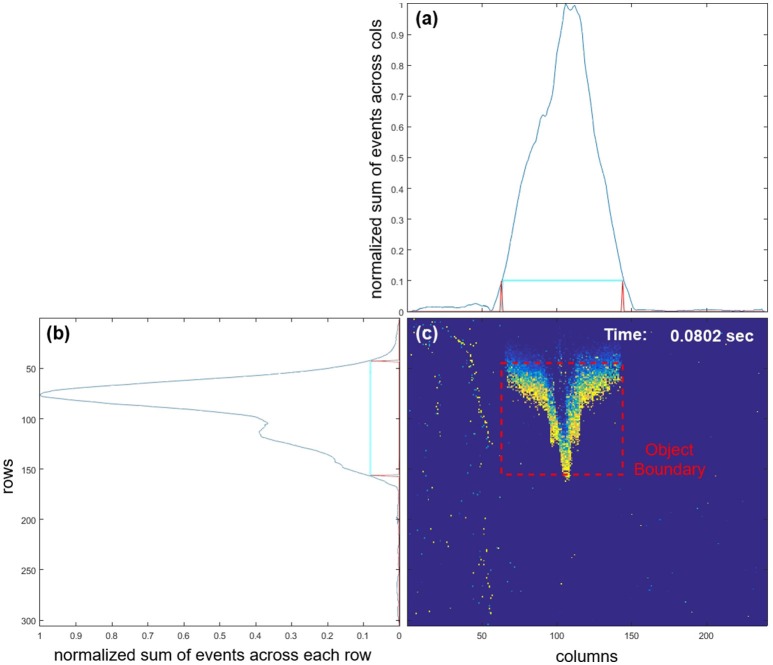
Screenshot from a live demonstration of the airplane drop test after 0.08 s. (a,b) are a smoothed summation of recent events across columns and rows, respectively. The smoothing was performed by using an 8-pixel wide rectangular moving average window. Due to the relatively high speed of the airplane these summations, when normalized and thresholded at 0.1, could reliably be used to extract the fast-moving airplane from the static background or slower moving objects. The generated target object's boundary is shown in (c). Note that movement of the body of the author (light vertical trace on the left) as he drops the airplane is slow relative to the airplane and generates relatively few events and so does not reach even the low set (th = 0.1) detection threshold.